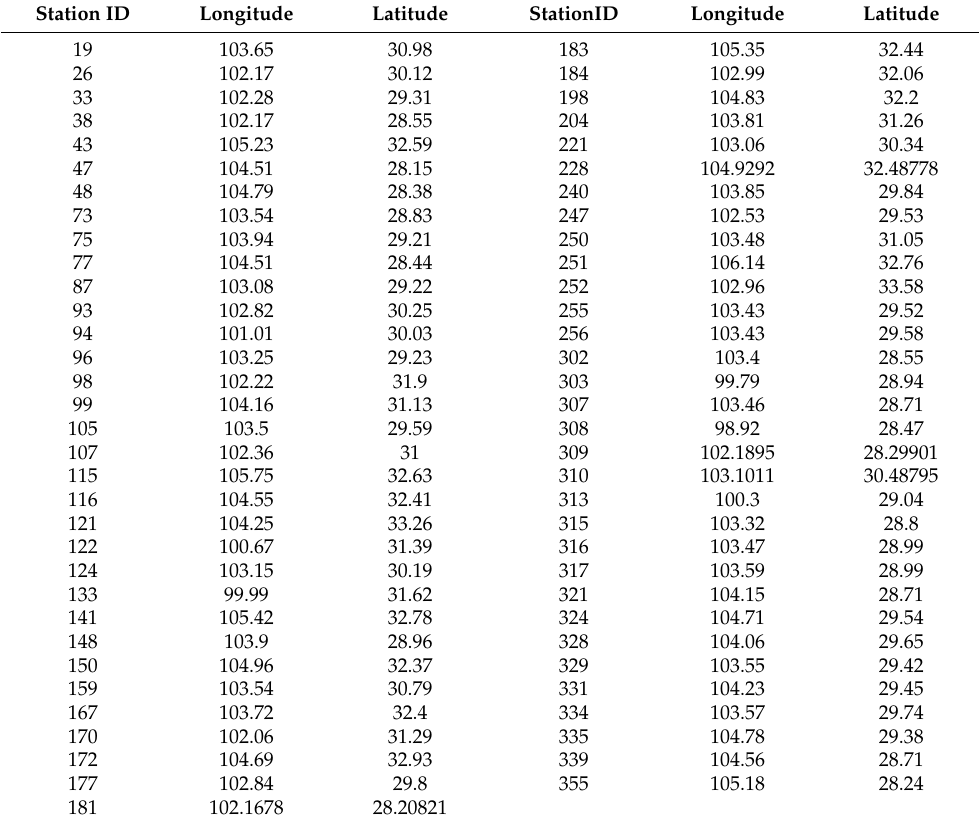
Table 3. Stations used in the